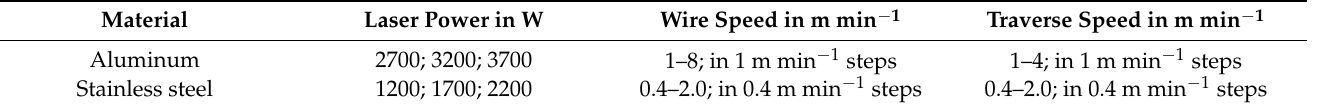
Table 2. Parameter combinations of the full factorial design used to identify the process window.